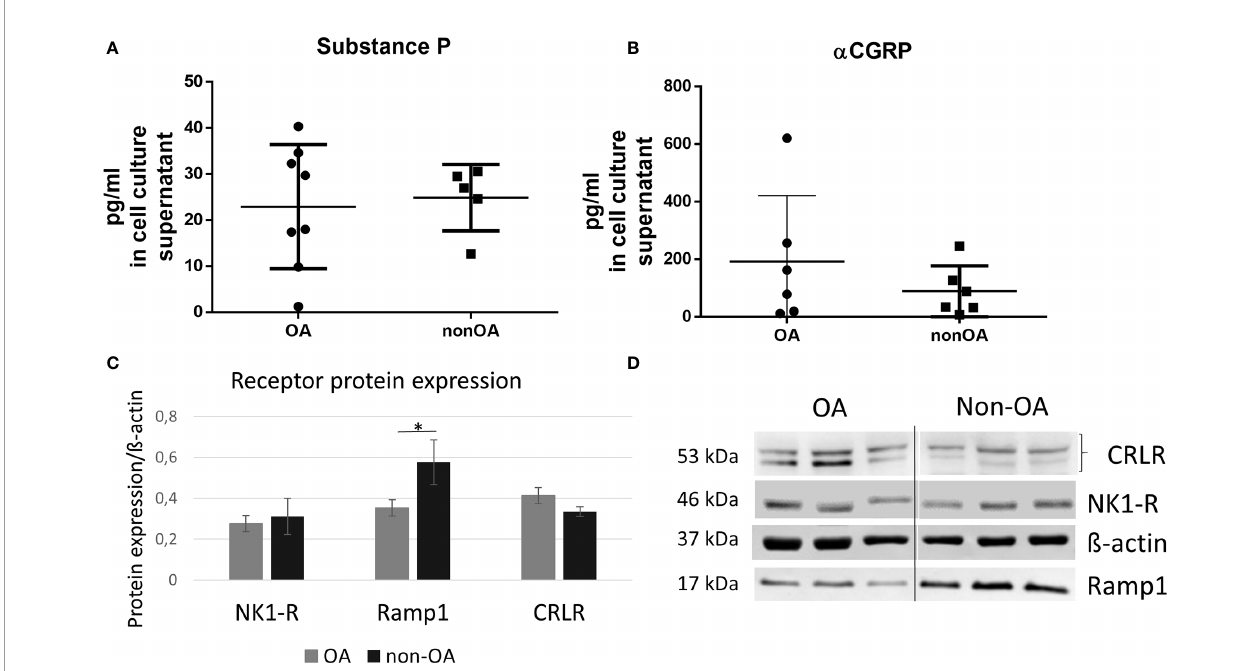
FIGURE 1 | Protein biosynthesis of SP, a CGRP, NK1-R and CGRP-R (CRLR and Ramp1) in OA and non-OA chondrocytes. (A, B) Protein concentration of SP and a CGRP was determined in the cell culture supernatants with ELISA, n = 5-8. (C) Relative receptor protein expression was determined densitometrically. Expression of b -actin served as endogenous loading control, n = 3. (D) Representative Western Blot images showing CRLR (~53 kDa), NK1-R (~46 kDa), Ramp1 (~17 kDa) and b -actin (~37 kDa) protein bands in chondrocyte lysates from OA- and non-OA donors (n = 3 different donors for each group). Results are means +/- SD; one sample t-test *p ≤ 0,05; OA, osteoarthritis; SP, substance P; a CGRP, alpha-calcitonin gene-related peptide; NK1-R, neurokinin 1 receptor; CRLR, calcitonin receptor-like receptor; Ramp1, receptor activity modifying protein